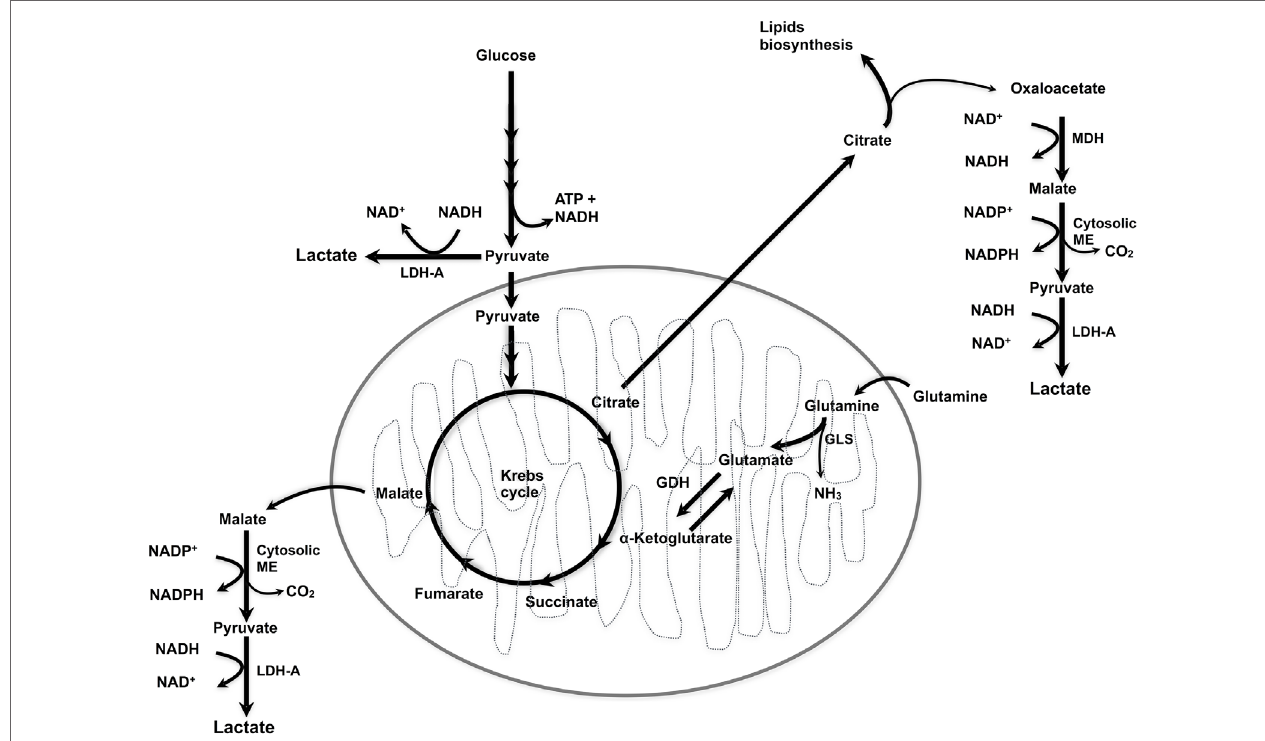
FiGURe 1 | Lactate synthesis . ME, malic enzyme; MDH, malate dehydrogenase; LDH-A, lactate dehydrogenase A; GLS, glutaminase; GDH, glutamate